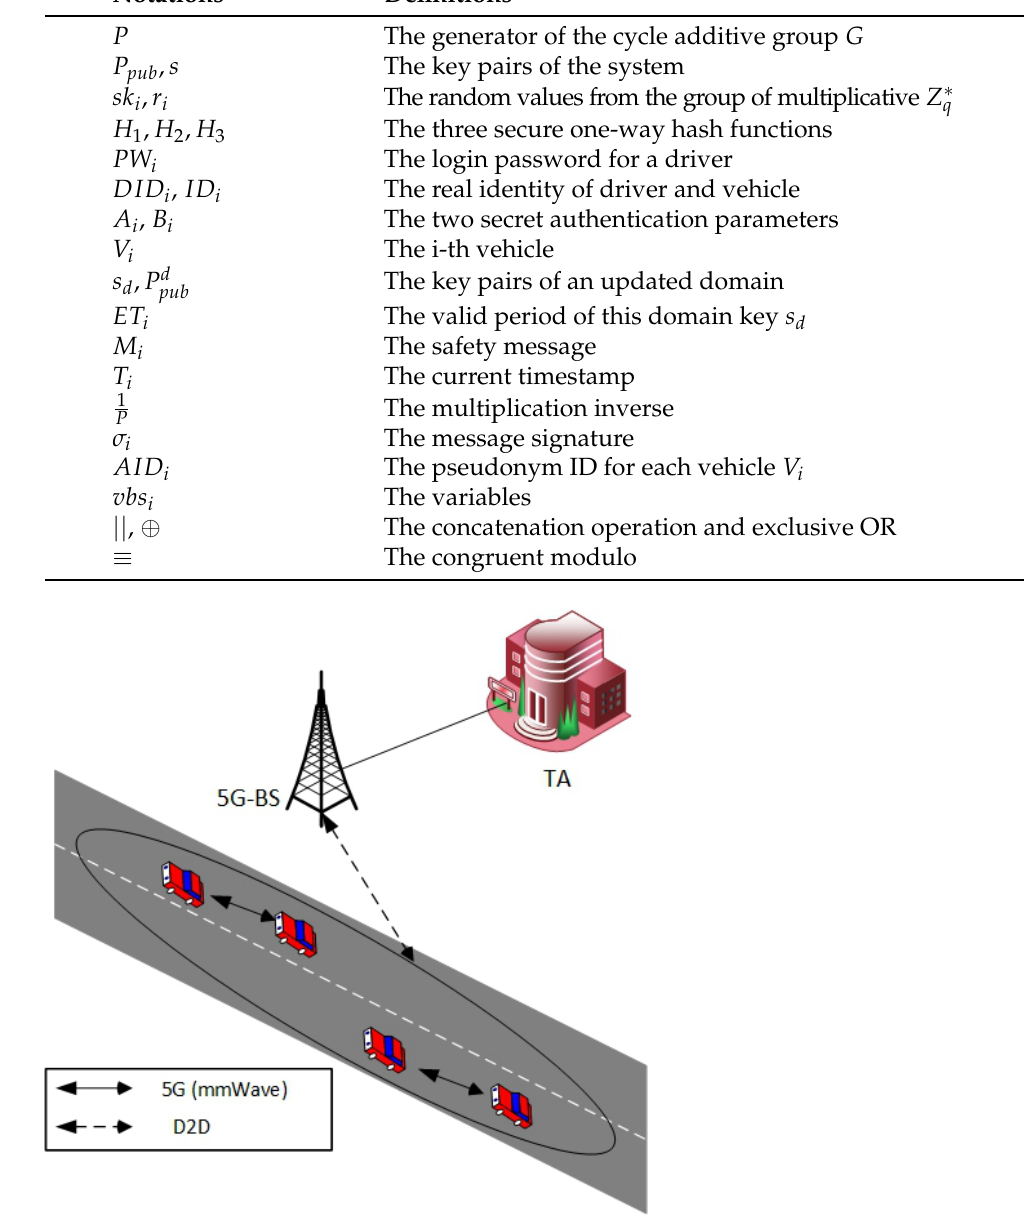
Figure 1. The network model of 5G-enabled vehicular